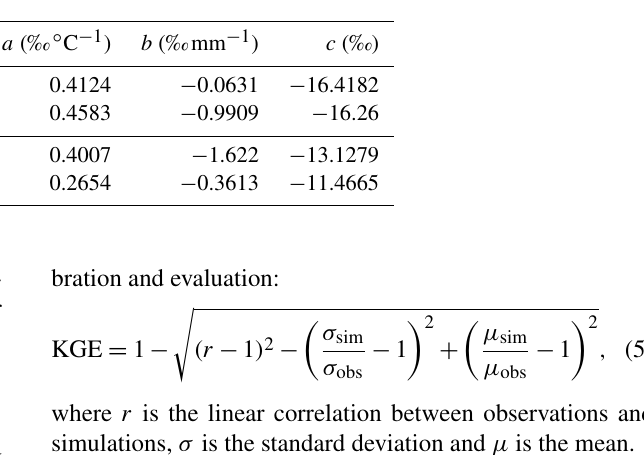
Table 2. Parameters obtained for the regression models for snow and rainfall using the IsoGSM dataset at the Tungsten and Caniapiscau sites. The thresholds for the null hypothesis are NNSE = 0 . 5 and KGE = 0 .